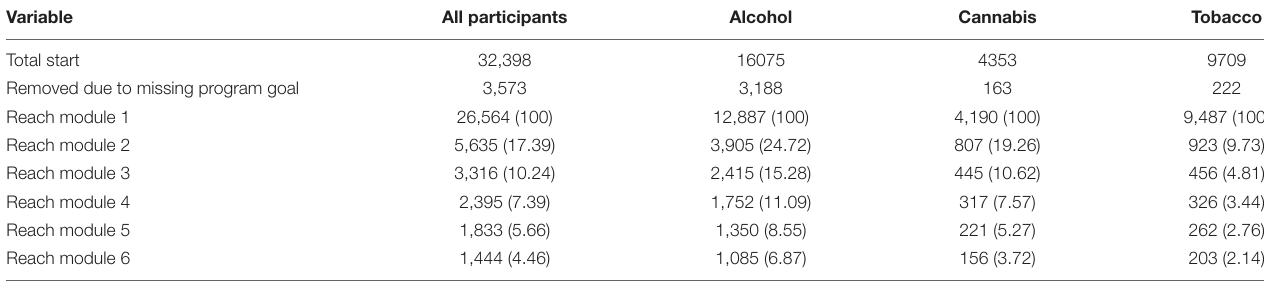
TABLE 2 | Distribution of participants that reach each Module and